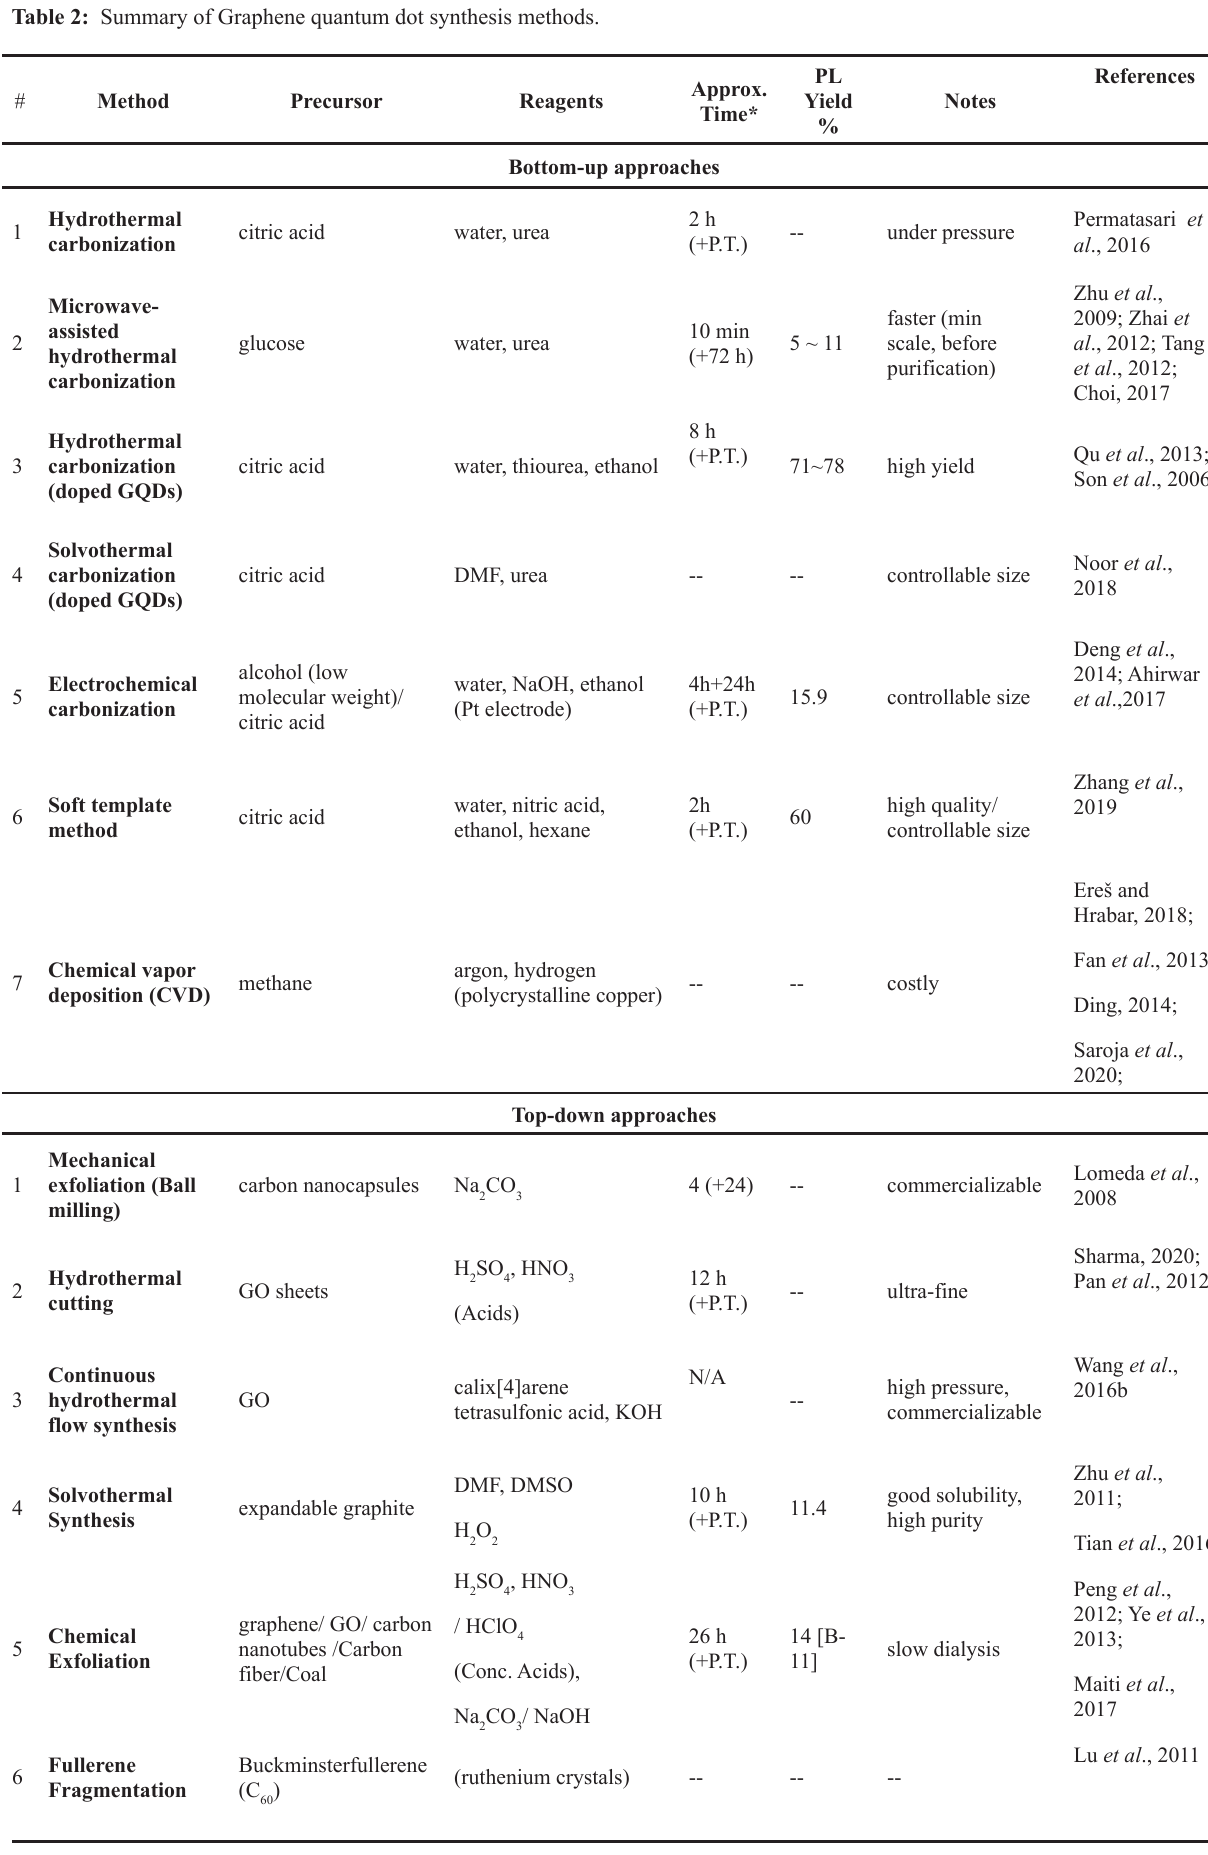
Table 2: Summary of Graphene quantum dot synthesis